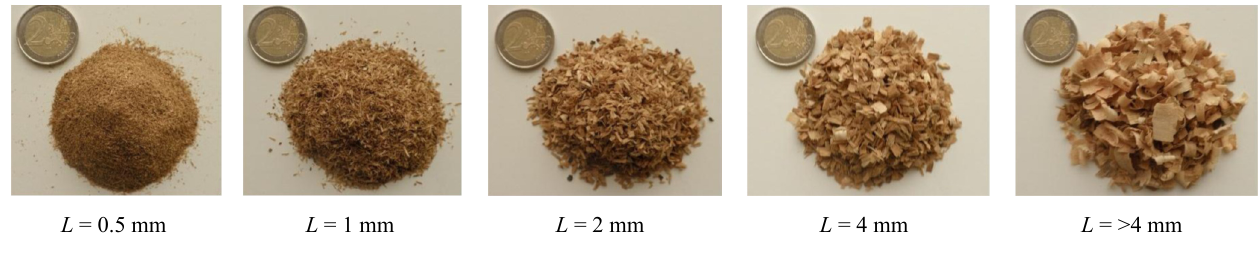
Figure 2. Raw material particle size distribution.